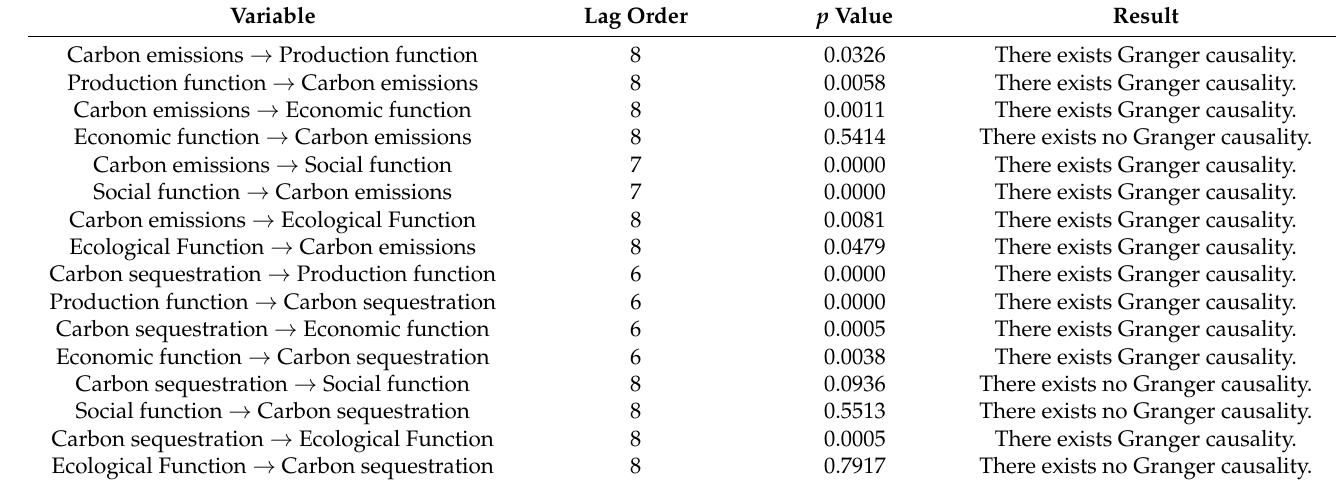
Table 5. Results of Granger causality